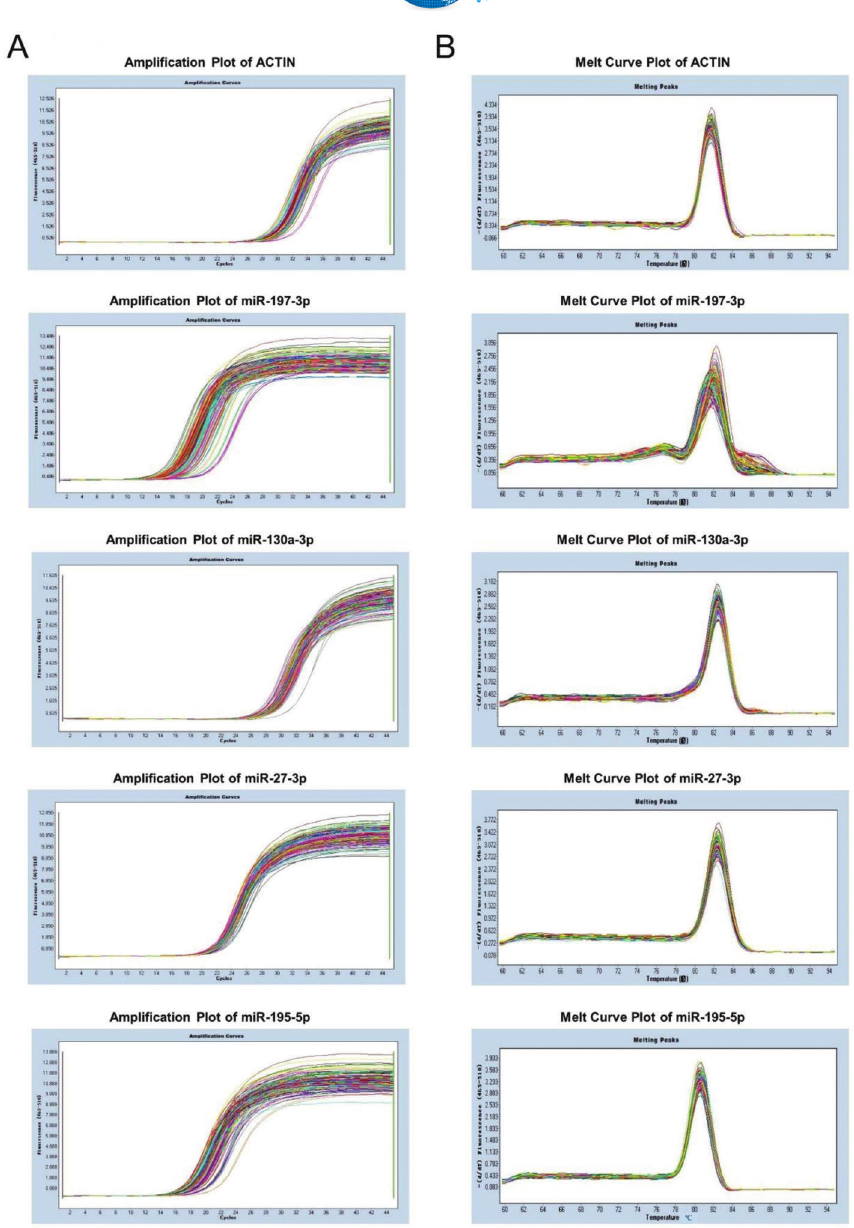
Figure S3 - Identification of differentially expressed miRNAs among patients and healthy donors. A-B Amplification plot ( A ) and melting curve plot ( B ) of ACTIN, miR-197-3p, miR-130a-3p, miR-27-3p, and